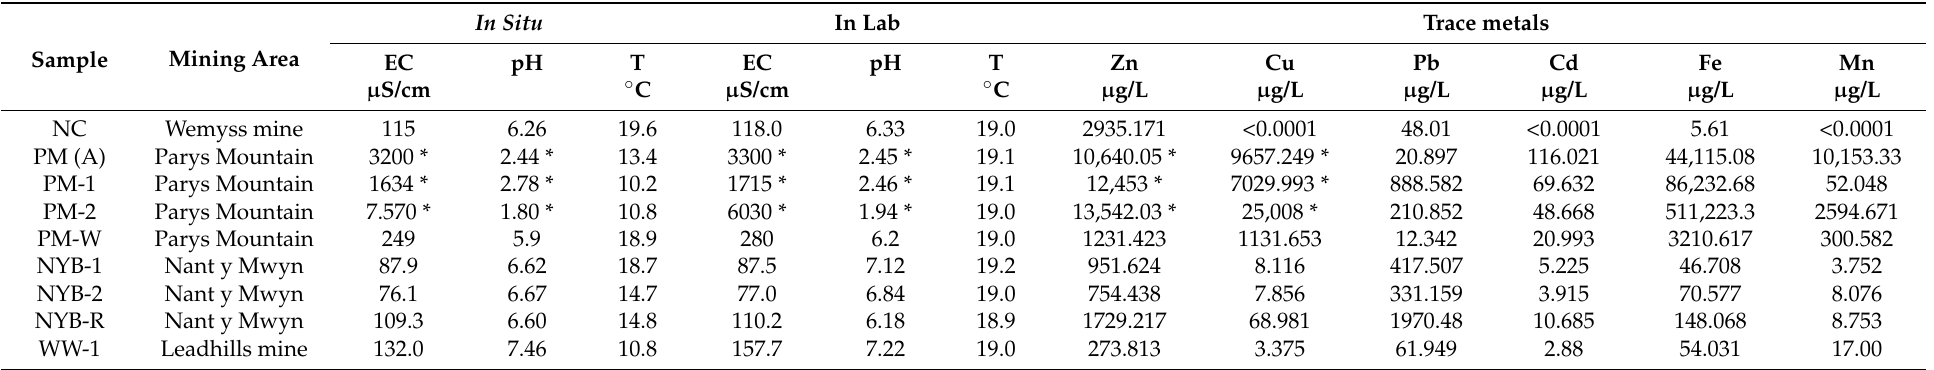
Table A1. Illustrates physicochemical parameters (EC, pH, T) for mining-impacted water samples measured in both field and lab, when were performed microwave measurements. Trace metals concentrations analysed using ICP-MS and/or ICP-OES for the collected mining-impacted water samples are also